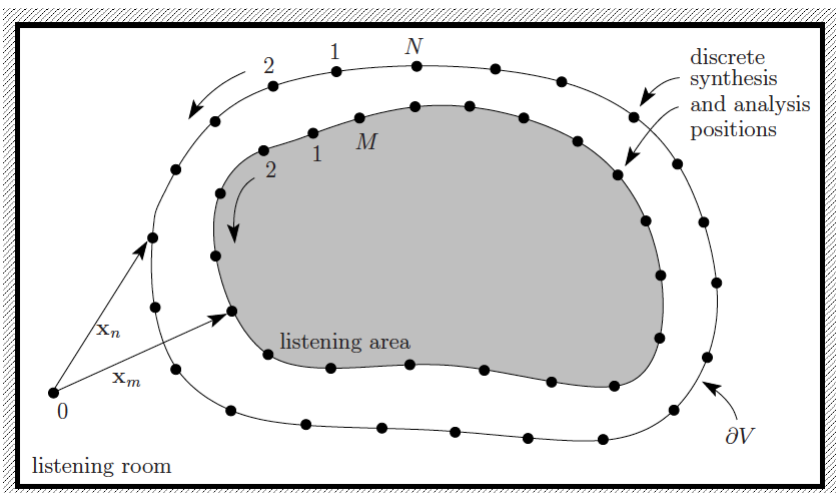
Figure 9. Application of the Helmholtz integral equation (HIE) to room compensation and spatial sampling of the loudspeaker and microphone